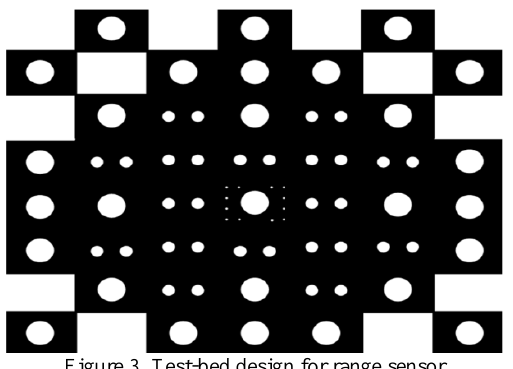
Figure 3. Test-bed design for range